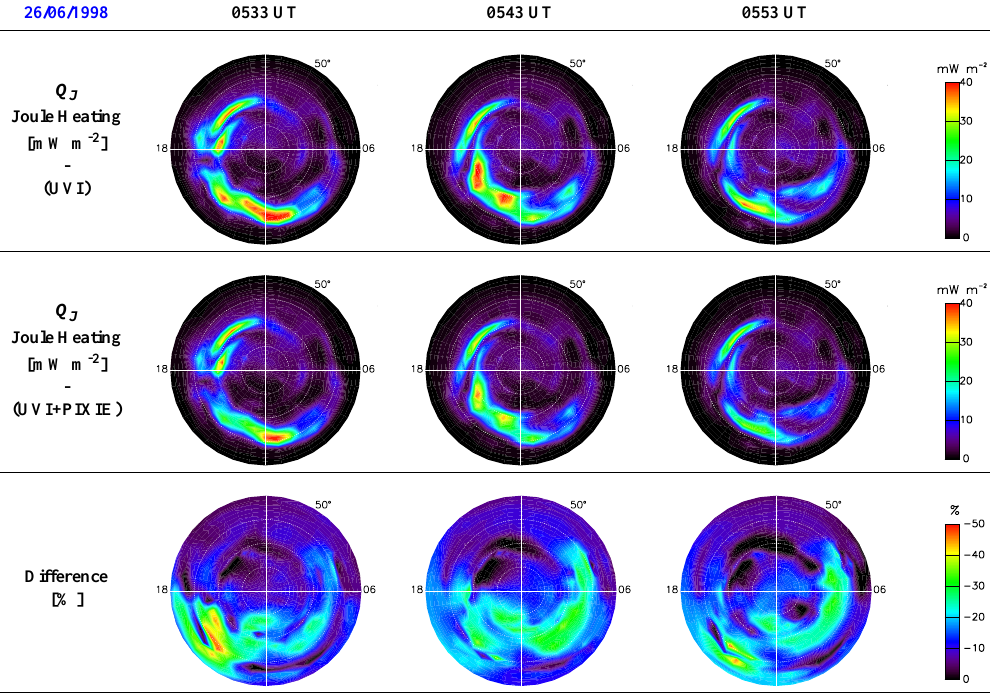
Fig. 6. Polar plots of Joule heating derived without (upper row) and with (middle row) PIXIE data between 05:30 and 06:00 UT on 26 June, 1998. The differences in percent when including the PIXIE data are presented in the bottom